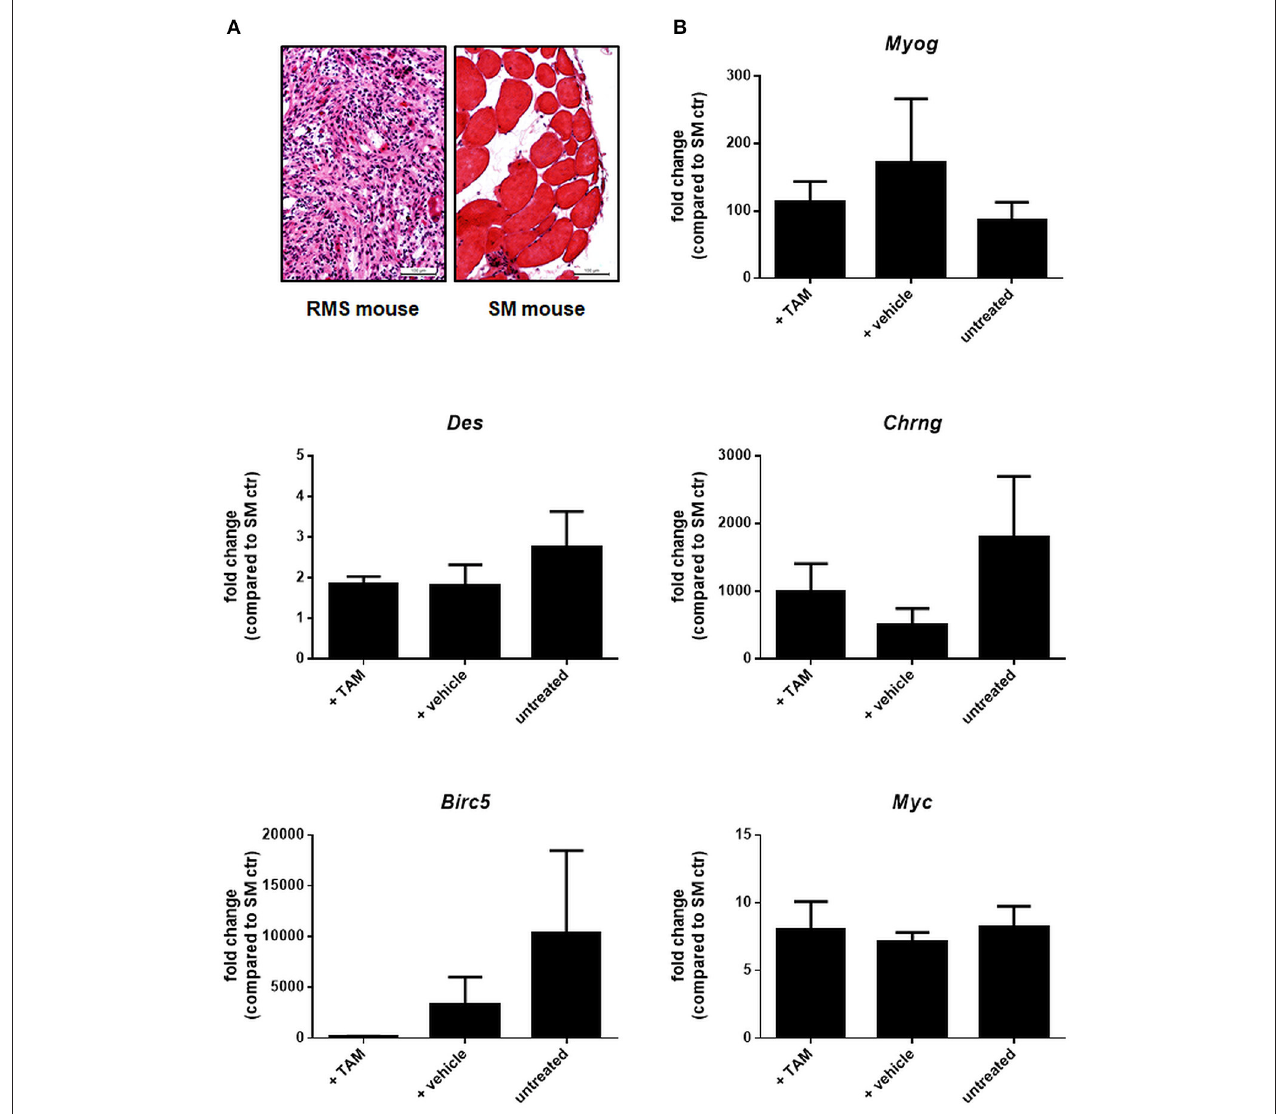
FIGURE 10 | Expression of selected muscle differentiation markers and β -catenin target genes in ß-cat fl / fl Ptch del / + Myf5 CreER / wt animals. (A) H&E staining of a representative RMS and corresponding skeletal muscle (SM) of the same mouse to check tissue for tumor or skeletal muscle components before RNA isolation. (B) qRT-PCR of muscle differentiation markers and β -catenin target genes of RMS from untreated ( n = 4), vehicle- ( n = 5), or TAM-treated mice ( n = 5). All data were normalized to GAPDH and are shown as fold change expression to the expression of the same gene within skeletal muscle (SM) of the respective mouse, which was set to 1. Bars show the mean and SEM of one cohort and represent measurements in technical duplicates. One-Way ANOVA with Dunn’s test for multiple comparisons show no significant differences. Tam: tamoxifen-treated at an age of 4 weeks. Vehicle: vehicle-treated at an age of 4